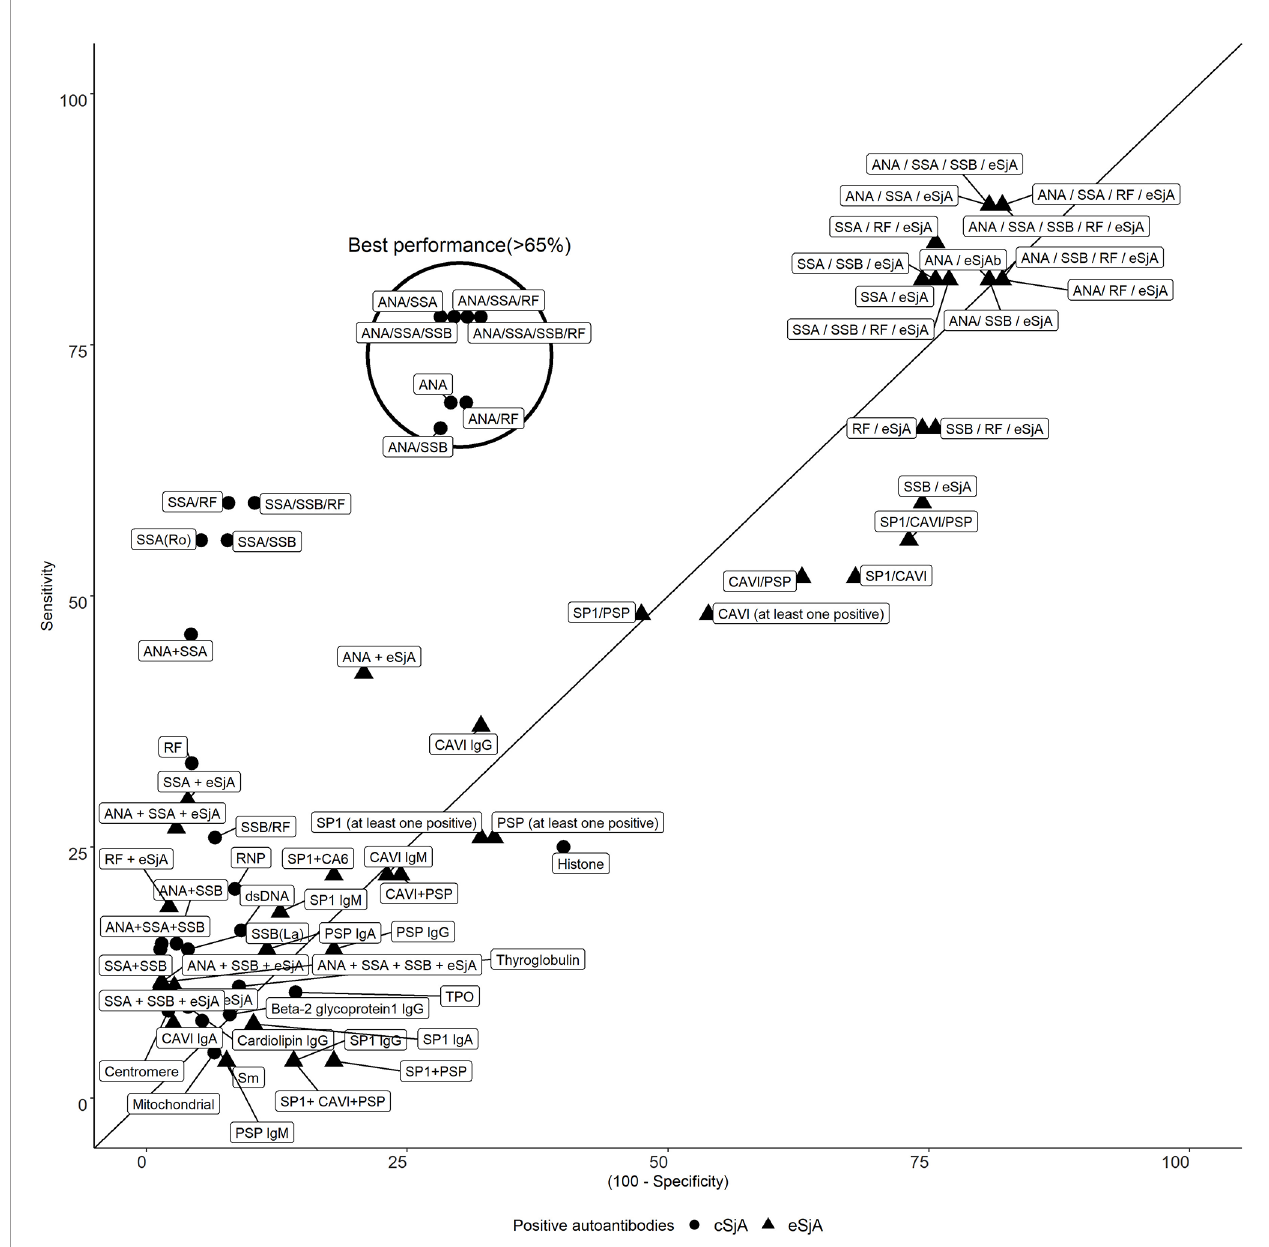
FIGURE 1 | Sensitivity and speci fi city of cSjA or eSjA in single/combination. The points within or near the circle indicate the best performance as having both sensitivity and speci fi city above 65%. No eSjA points are found in this